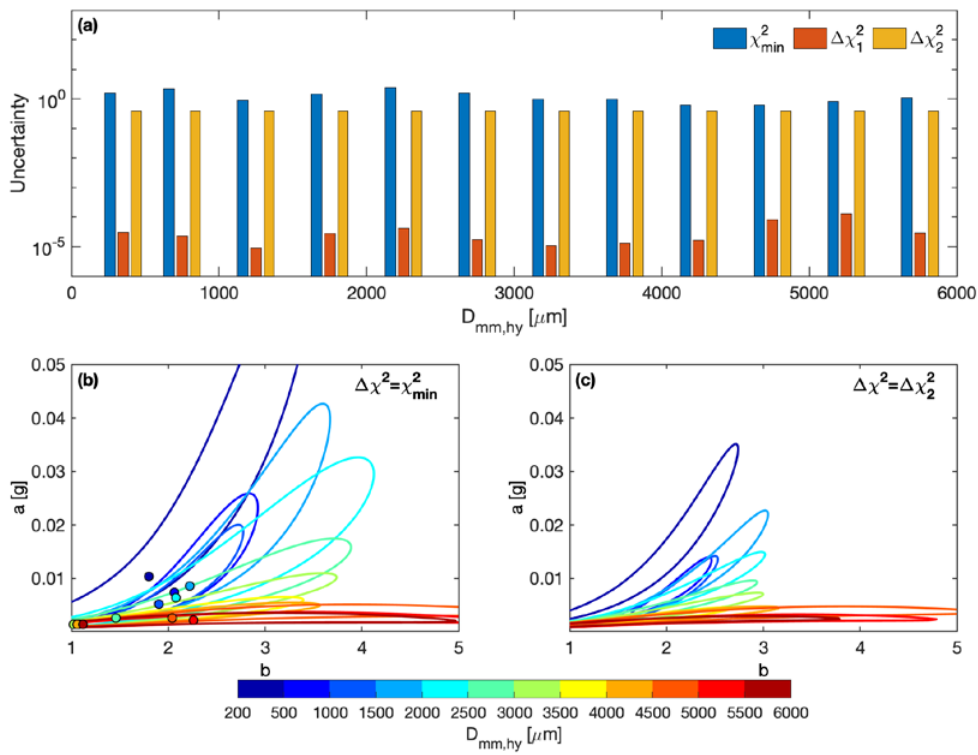
Figure 1. ( a ) Sources of uncertainties as a function of D mm , hy ; ( b ) Equally plausible surfaces determined by χ 2 = 2 χ 2 min for di ff erent D mm , hy range bins indicated by the color bar beneath the plot. Circles with corresponding colors denote the locations of χ 2 min for each D mm , hy bin. ( c ) Same as ( b ) but equally plausible surfaces determined by χ 2 = χ 2 min + ∆ χ 2 .